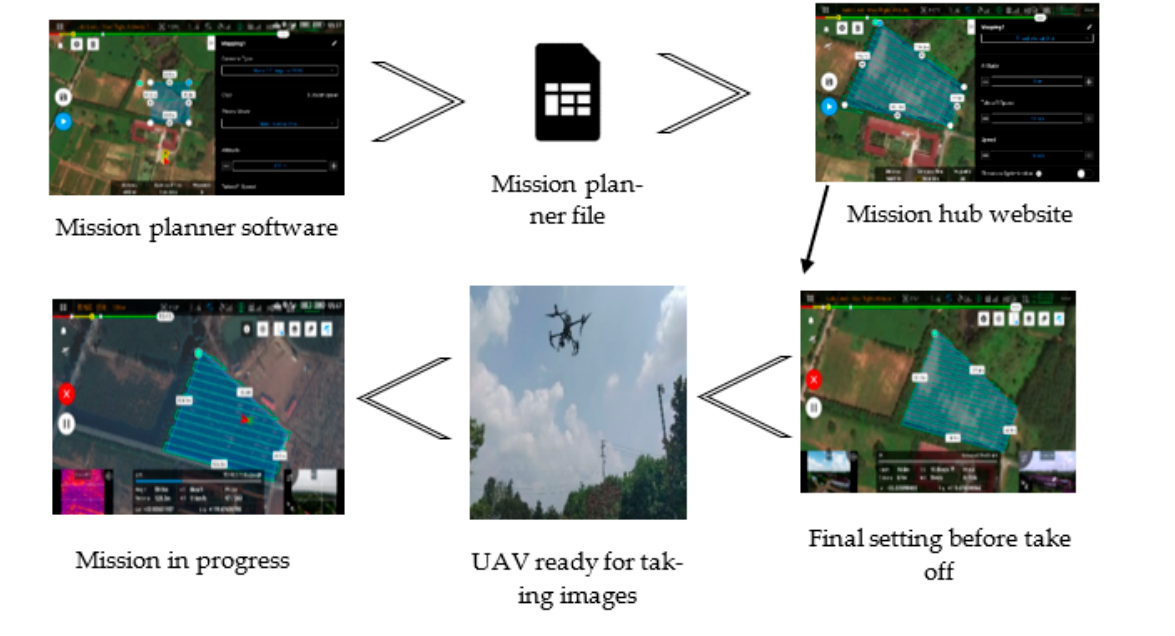
Figure 2. UAV flight plan over the experimental field. Table 2. The detailed specification of UAV and sensor used for the experiment.